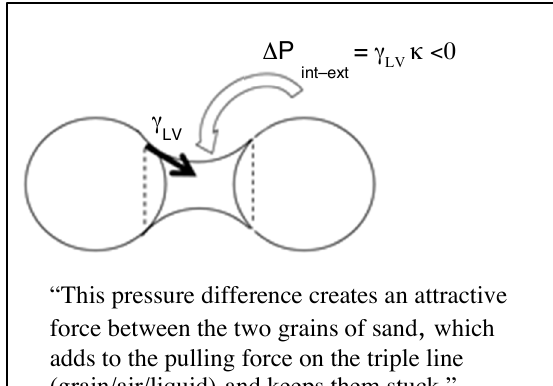
Fig. 4. An explanation of the attraction between two grains in hydrophilic contact with a liquid [11]